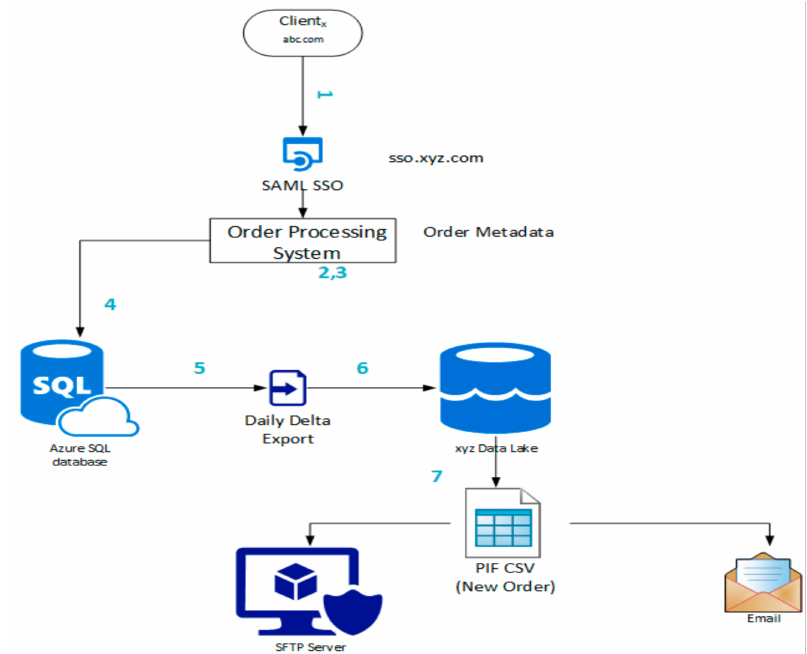
Figure 2. Medium risk mitigation